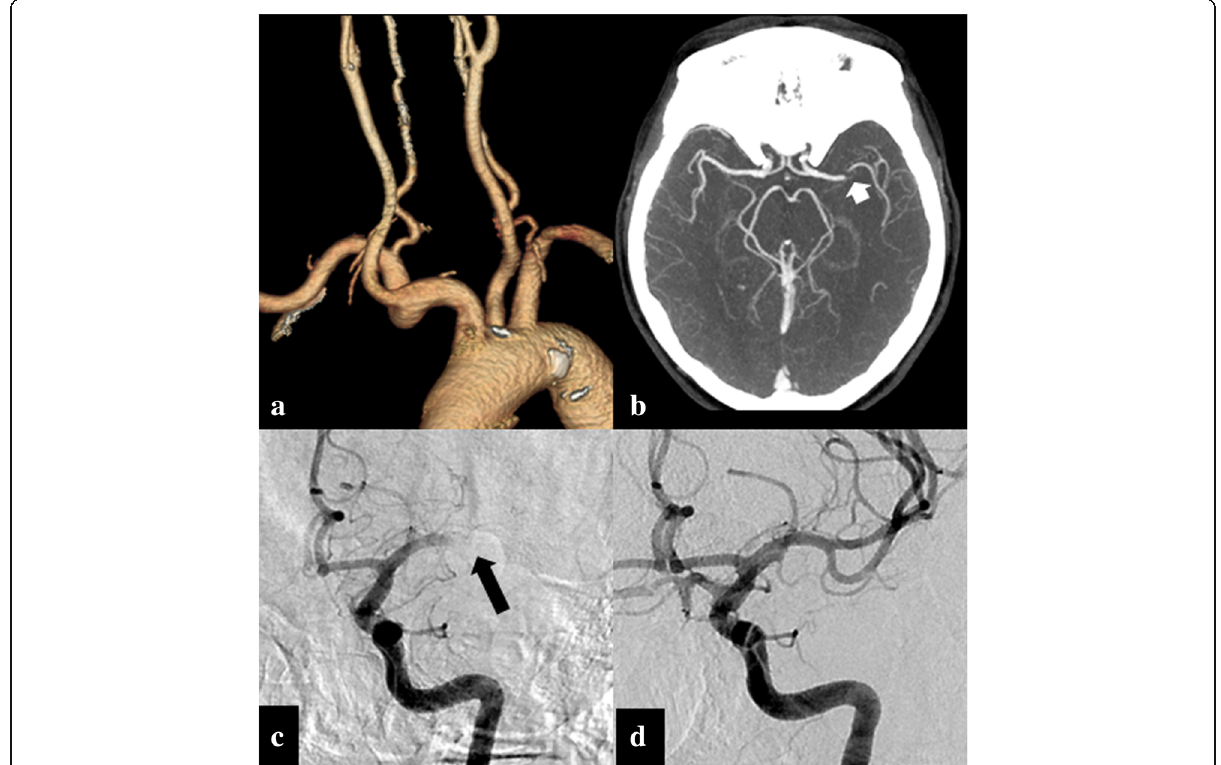
Fig. 2 This 78-year old woman with atrial fibrillation presented with sudden onset of right-sided hemiplegia and aphasia. CT-angiography (CTA) with 3D volume rendering shows normal patency with moderate tortuosity of the cervical carotid arteries ( a ). An axial maximum intensity projection (MIP) reformation of the CTA demonstrates an occlusion in the M1 segment of the left MCA ( b , white arrow). The patient was referred immediately for EVT. Catheter digital subtraction angiography, in anteroposterior (AP) projection, confirmed the left MCA M1 segment occlusion ( c , black arrow). Subsequently, a successful endovascular removal of the thrombus was performed ( d , post EVT AP projection angiography). At clinical follow-up, a complete resolution of the neurological symptoms occurred soon after